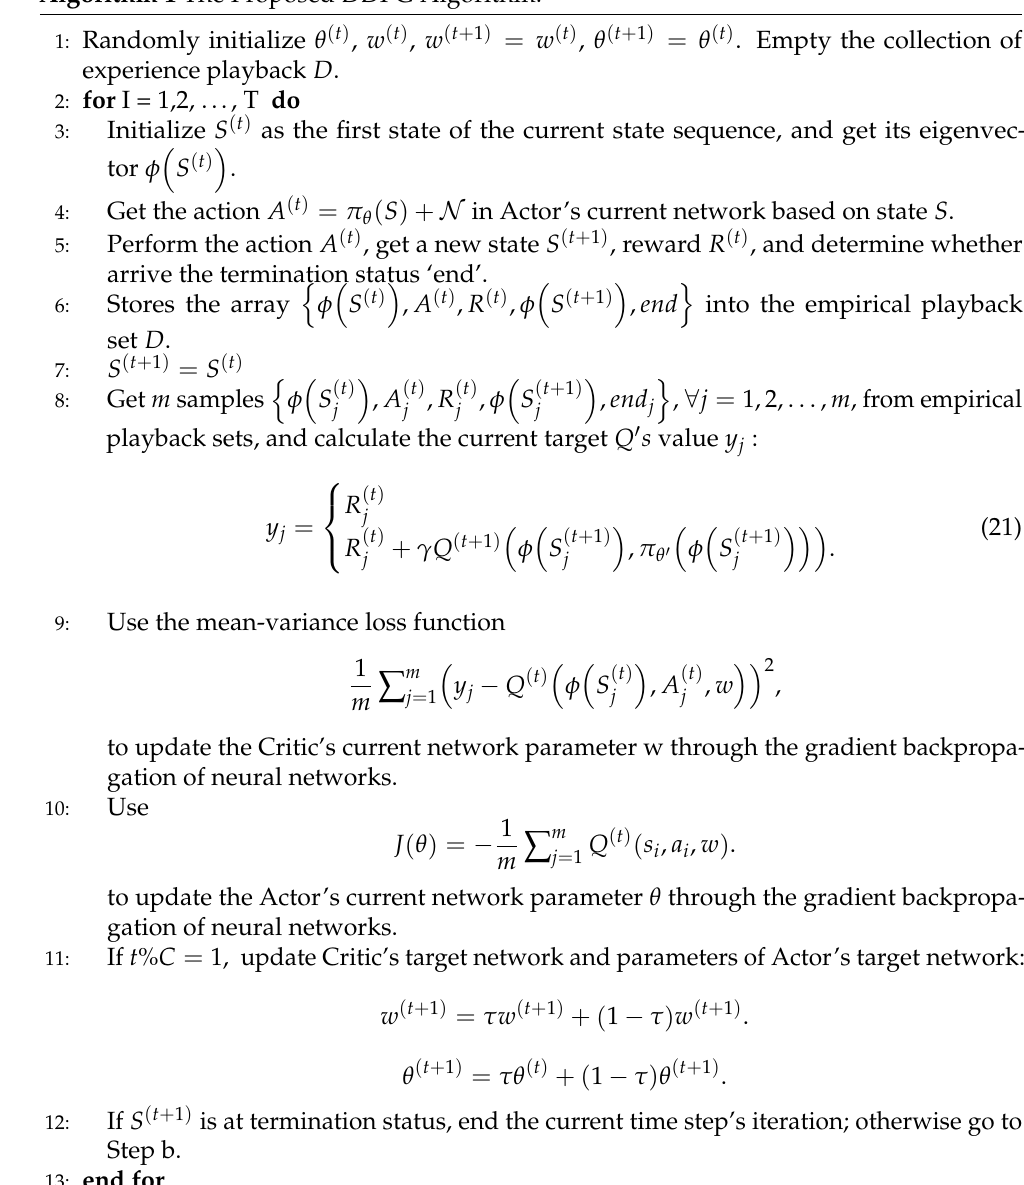
Algorithm 1 The Proposed DDPG